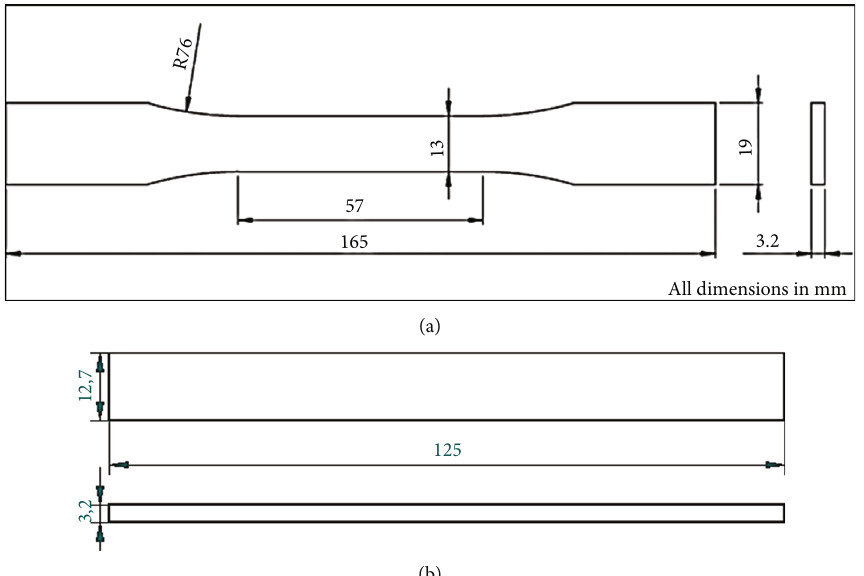
Figure 3: (a) Tensile test specimen used in the present work (ASTM D638-TYPE 2 standard dimensions). (b) Flexural test specimen used in the present work (ASTM D790 standard dimensions).